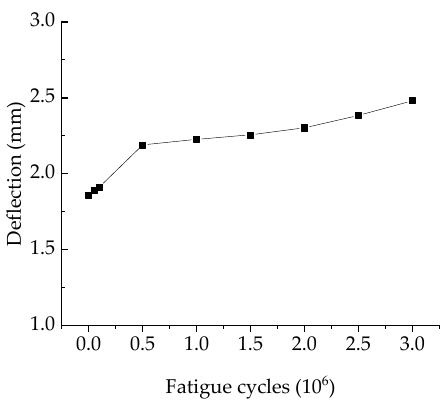
Figure 20. The relationship between the mid-span deflection and fatigue cycles of the reinforced P3.